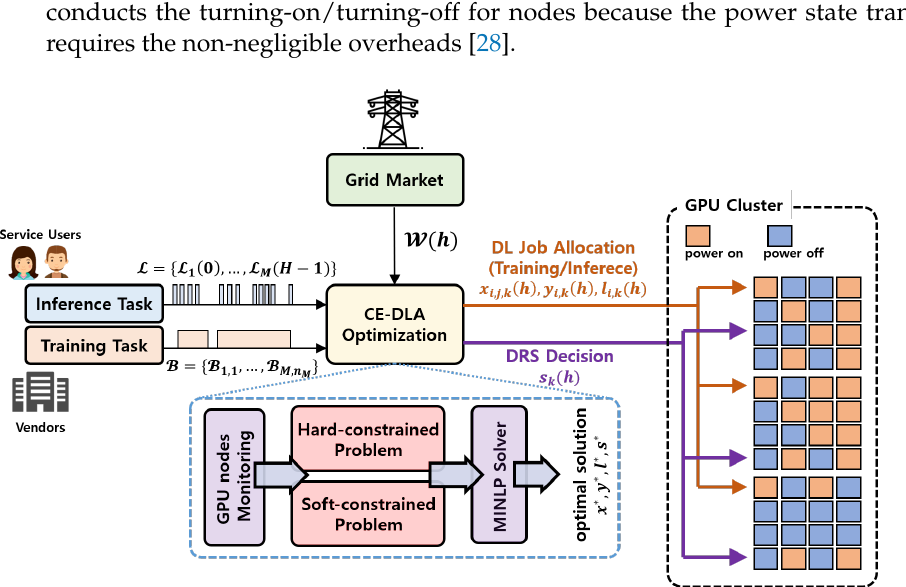
Figure 1. The system structure with the proposed cost efficient deep learning allocation (CE- DLA)